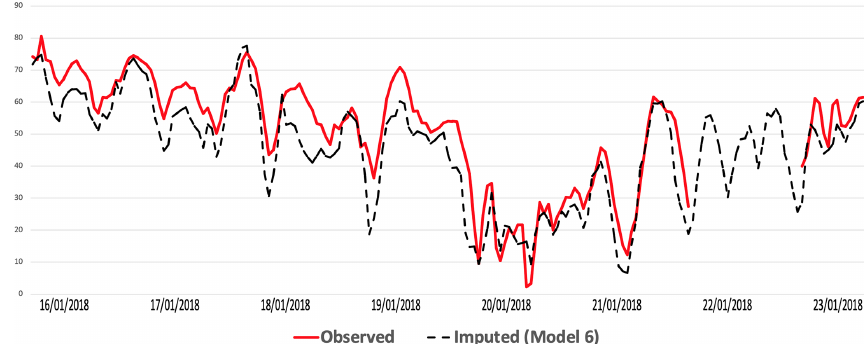
Figure 15. Imputed (black) and real (red) TS comparison for O 3 at Birmingham Acocks Green station from 16 to 23 January 2018.